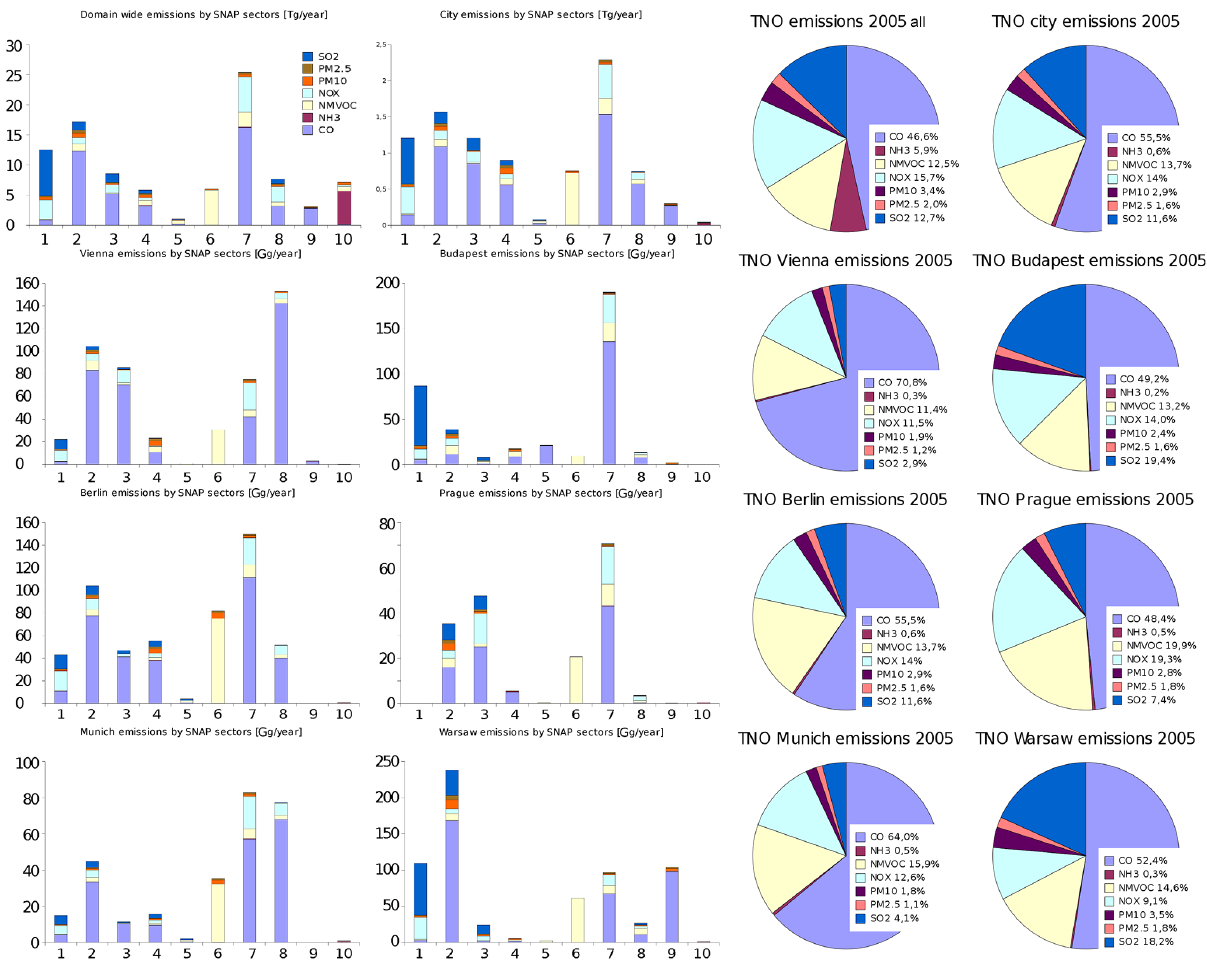
Figure 2. First two columns: annual emissions (2005) per sector for the entire domain in Tgyr − 1 , for all the cities in Tgyr − 1 and for six selected cities from the domain in Ggyr − 1 . Right two columns: the same as the first one, but for the relative contribution of individual pollutants in